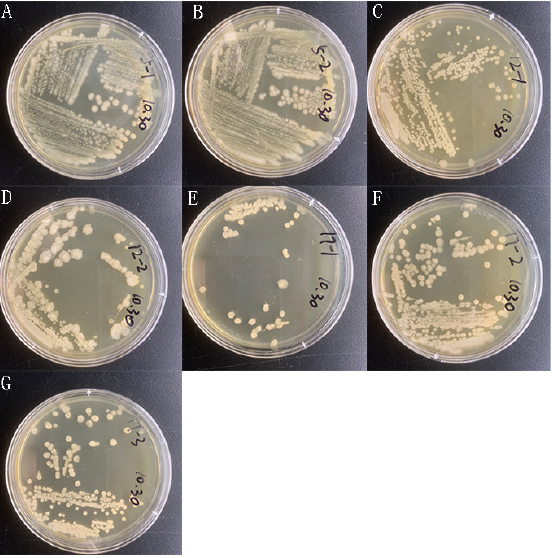
Figure A1. Isolation of agarwood saprophytic bacteria. A–G : Bacterial suspension of Bs-1 to Bs-7 were dipped and streaked on the PDA medium. Then the medium was cultured at 37 °C for 12 h.